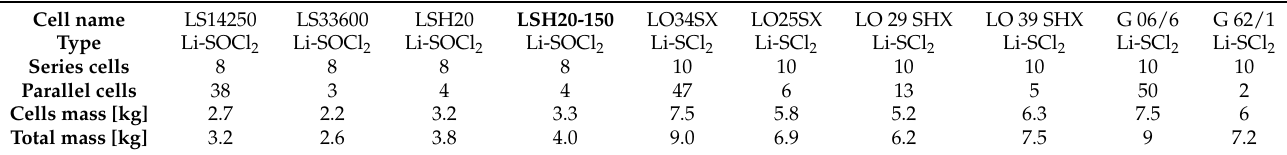
Table 4. Required number of non-rechargeable cells and corresponding mass, excluding the module mechanical assembly. Cell